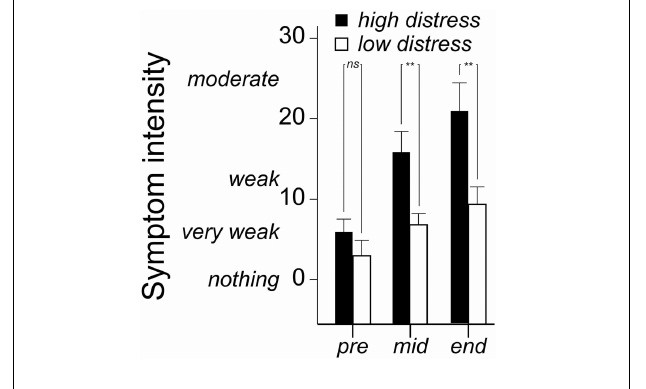
FIGURE 4 | Mean ( + standard error) ratings of eye irritation, nose irritation, skin irritation, throat irritation, shortness of breath, concentration difficulties, dizziness, tiredness, headache, and nausea before (pre), in the middle of (mid) and at the end of the n- butanol exposure session. Ratings are made on a Borg CR-100 scale. P- values refer to the ANOVA parameter estimates ( ∗∗ p < 0 . 01).